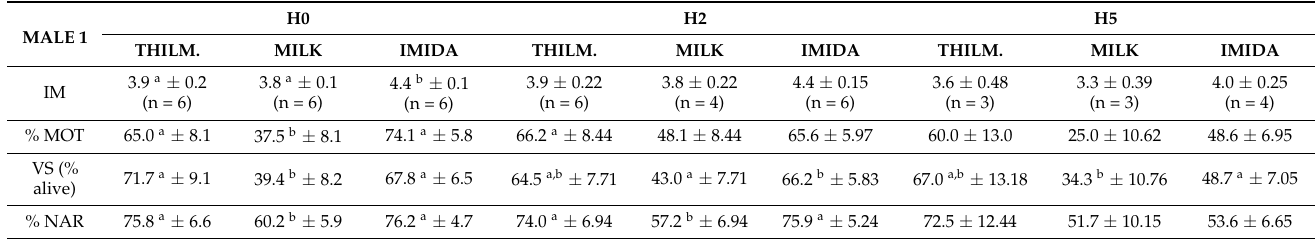
Table 10. Average semen quality parameters by subjective microscopic evaluation for male 1 in endurance test, according to extender.